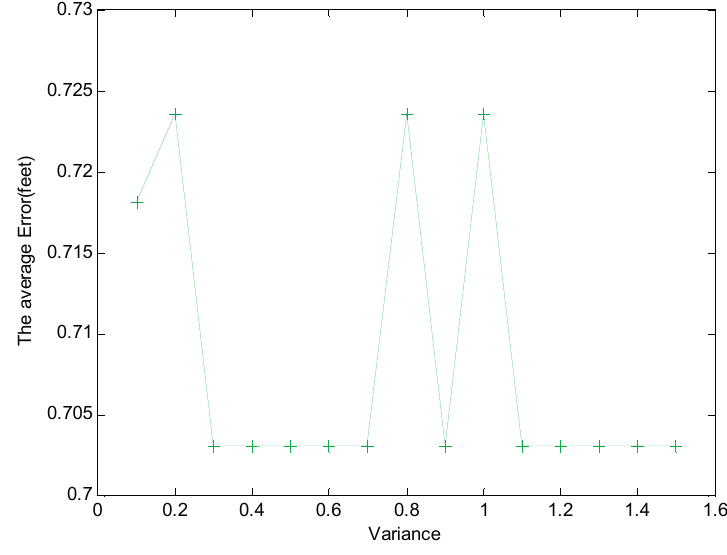
Figure 8. Average errors for the different thresholds of variance ( δ ).